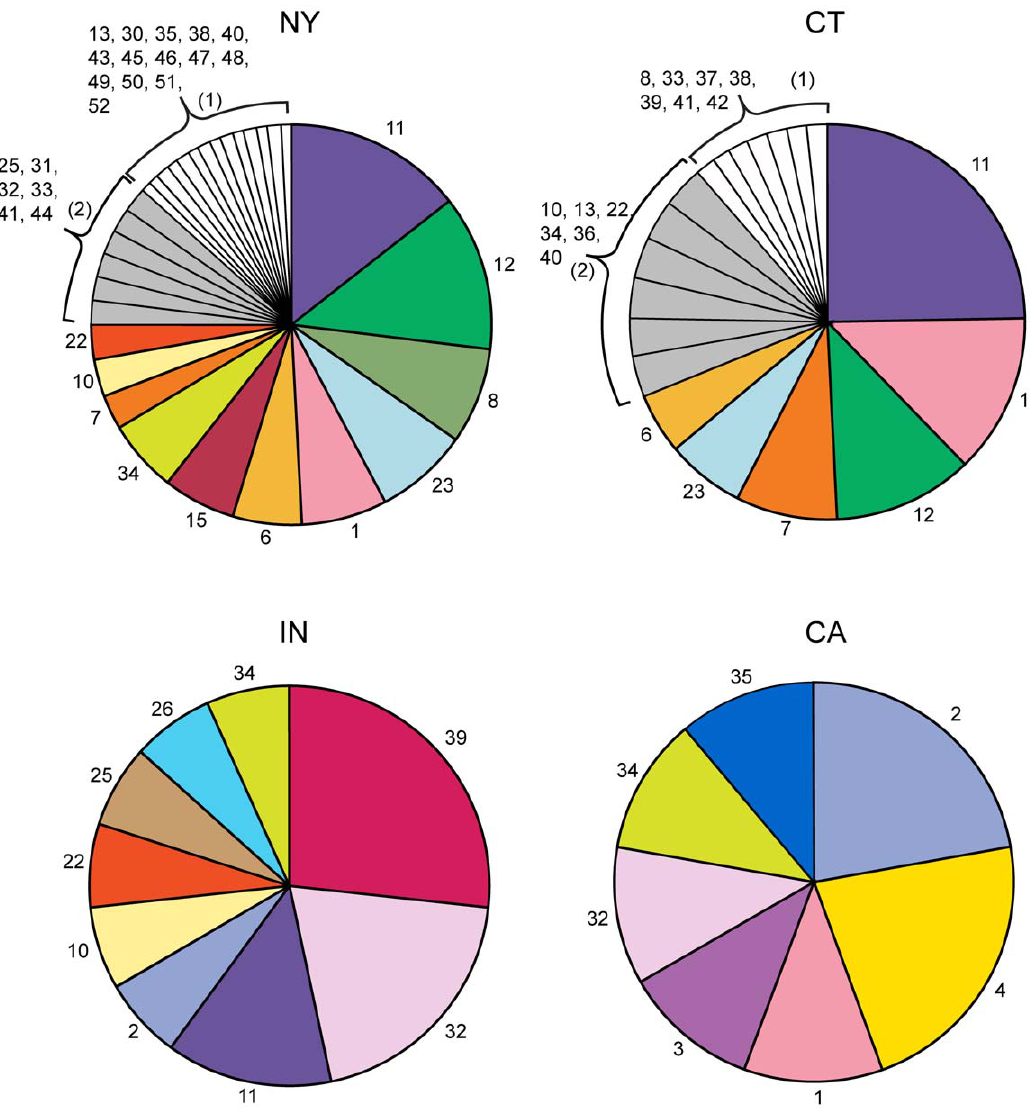
Figure 1. B.burgdorferi s.s. genotypes detected in NY, CT, IN, and CA. The number indicates the genotype and the pie size is relative to the proportion that the genotype was observed compared to all the genotypes in that region. The number of B. burgdorferi samples genotyped in each region was 104 for NY, 61 for CT, 14 for IN, and 9 for CA.